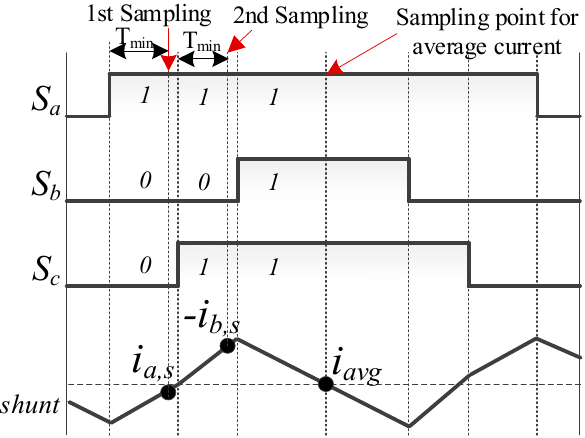
Figure 5. Switching patterns and current wave form of shunt resistor in sector 6.